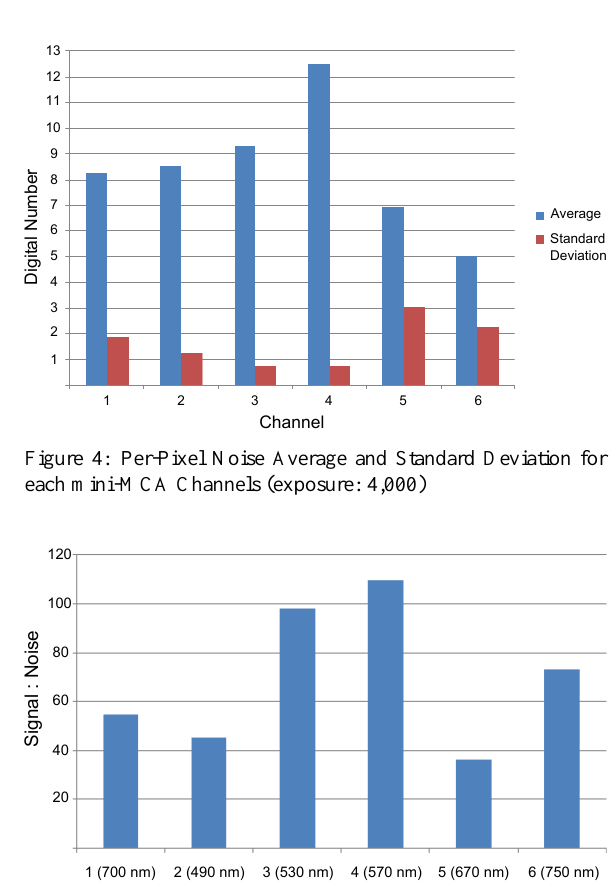
Signal-to-noise ratio was calculated as the ratio of the average im- age measurement post-dark offset subtraction to the standard de- viation of the dark offset imagery. An assessment of SNR reveals channel 4 and 3 to have generated the highest quality of data.